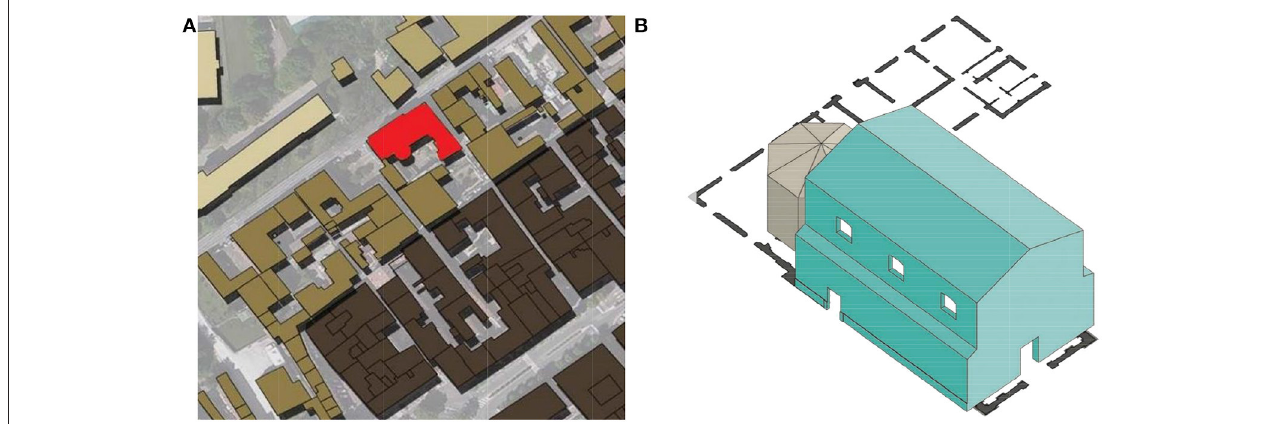
FIGURE 1 | Bird-eye-view (highlighted in red) (A) and original configuration (B) of the SS. Rosario ecclesiastic complex in Finale Emilia.